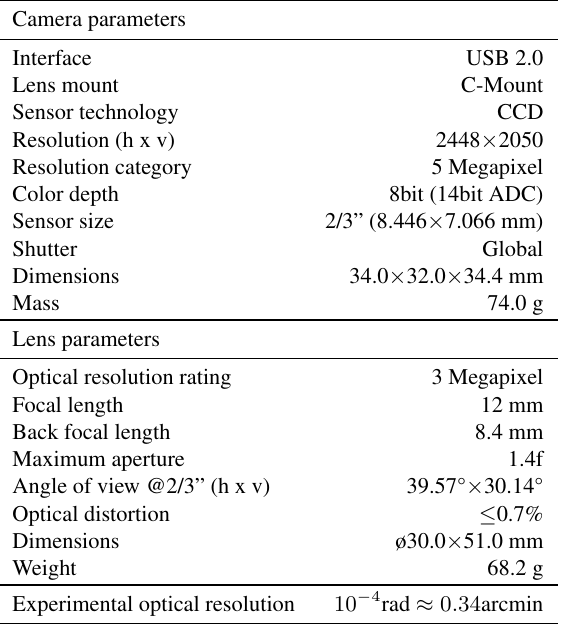
Table 1: UEye USB UI-2280SE camera and VS Technology B- VS1214MP lens specifications